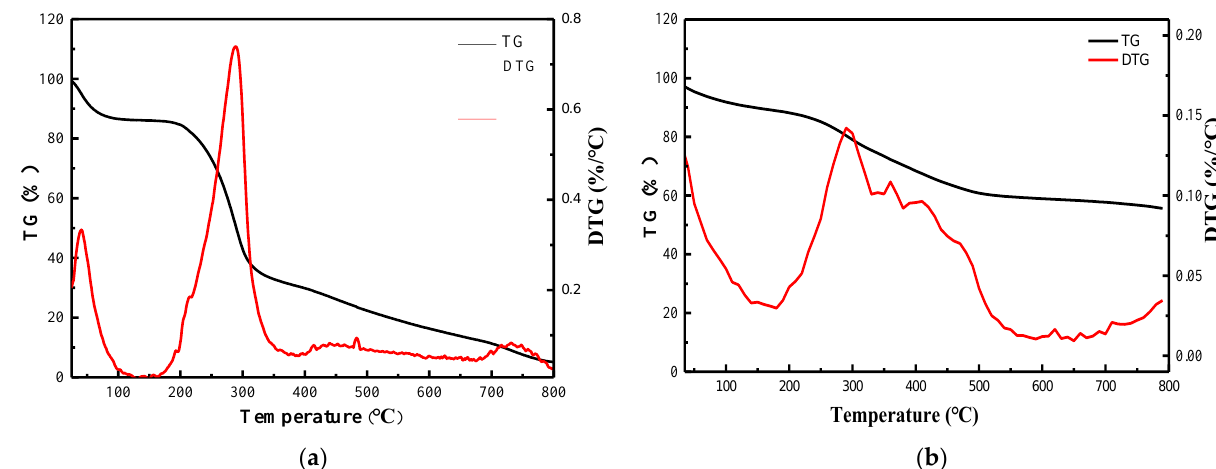
Figure 5. TG-DTG curve of BX and GMA BX-PA. ( a ) TG-DTG curve of BX. ( b ) TG-DTG curve of GMA BX-PA.